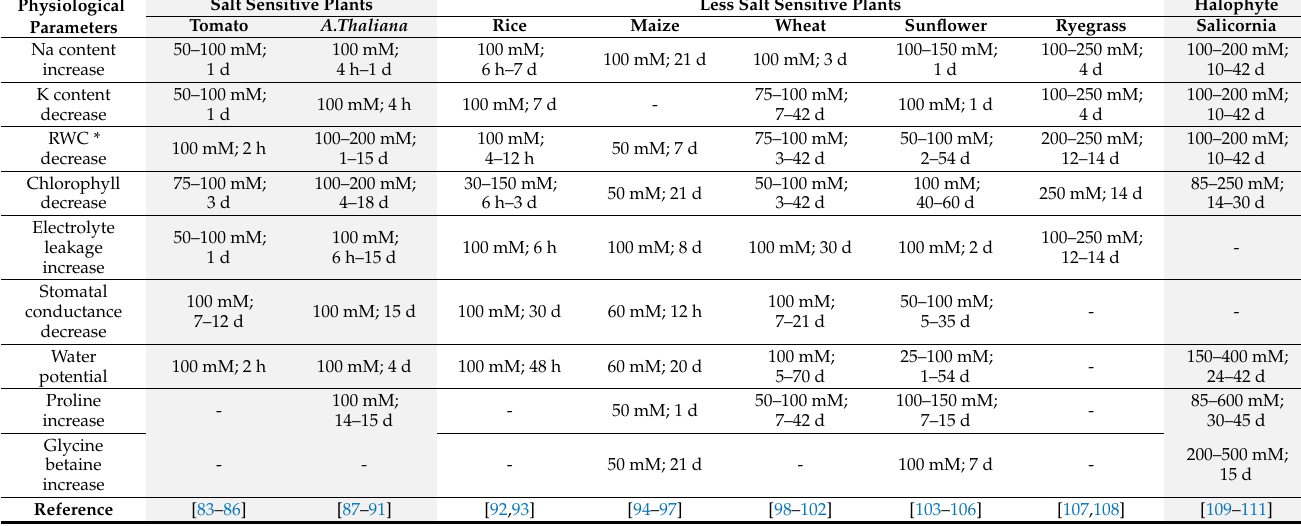
Table 1. Range of changes of the physiological parameters depend on time and concentration of NaCl application. Physiological